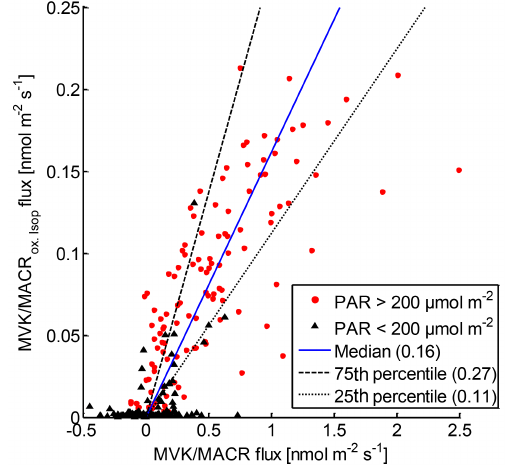
Figure 8. Scatter plot of the calculated MVK/MACR flux from oxi- dation of isoprene and the observed MVK/MACR flux. The correla- tion factor for the data is 0.81. The 1h data are separated to day and night values by a 200µmolm − 2 photosynthetically active radiation ratios of the daytime data have been cal- (PAR) threshold. The y x culated to determine the median and the 25th and 75th percentiles. The MVK/MACR flux from oxidation of isoprene was calculated using Eq.